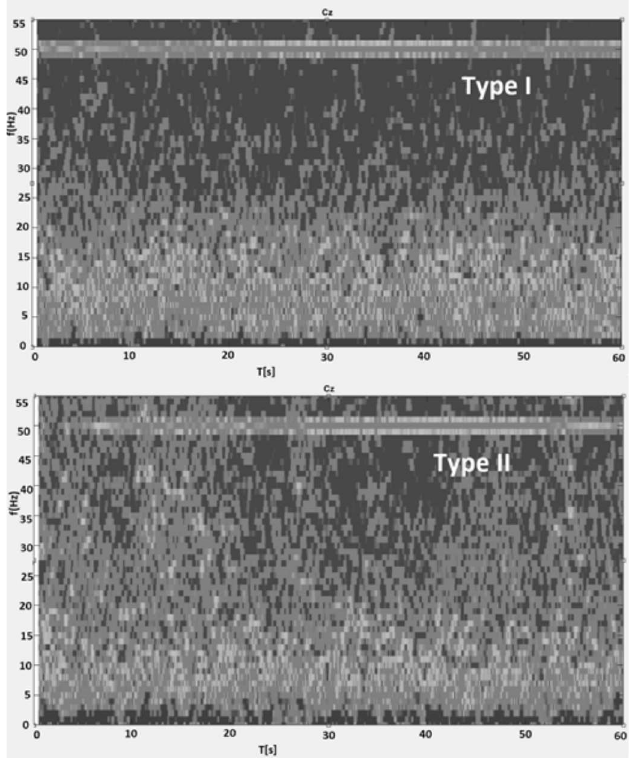
Figure 13. Two types of disorders (type I and II) –